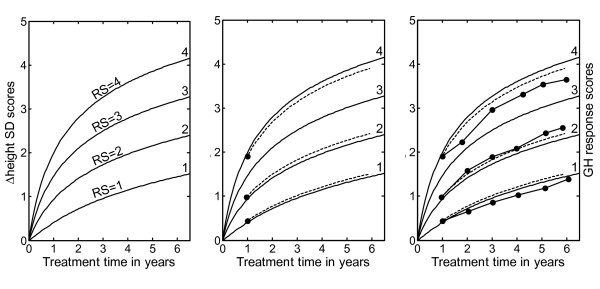
GH response chart for visualization of Response Scores (RS) on different levels (i.e. growth responses for children with variable individual responsiveness to GH). Left panel: The RS chart is given with 'isolines' ('channels') for RS = 1, 2, 3 and 4 which is indicated in the figure. For the individual child at treatment time 1 year (x-axis), the observed growth response (Δheight SDS) is found on the y-axis to the left and following the corresponding curve the individual RS can be found to the right. Middle panel: Observed first-year Δheight SDS on treatment for three prepubertal children from the validation group (filled circles). The individual calculated Response Score (dotted line) is found on the right axis. The function for the Response score is: RS(t) = (Δheight SDSobs - FBG(t))/FCU(t), where FBG(t) = elog (1 + t*(0.205 - 1/(1 + 2.1*t))) and FCU(t) = t/(t + 0.894); t = GH treatment time in years. Right panel: Individual Response Scores from the same three children, based on observed Δheight SDS on treatment at different time points (filled circles at treatment time 2, 3, 4, 5 and 6 years) in comparison with the predicted (dotted line). Response Score was consistent over time within an individual child, and the inclusion in the model of measurements made later than 1 year after the start of GH treatment are acceptable.